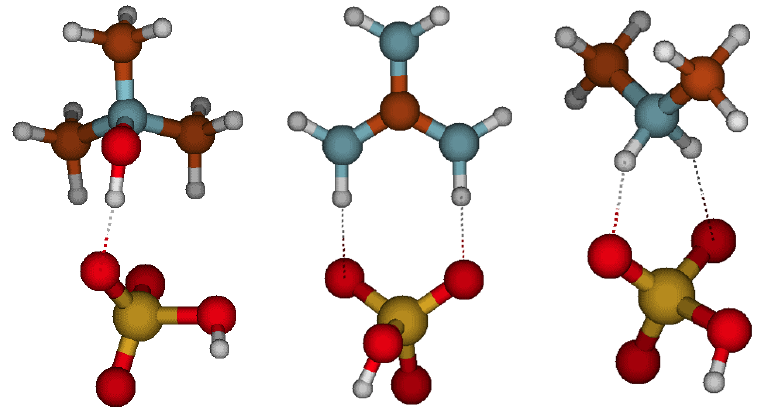
Figure 2. Molecular structures of sulfuric acid heterodimers with trimethylamine oxide (TMAO) ( left ), guanidine (GUA) ( middle ), and dimethylamine (DMA) ( right ). Color coding: Brown is carbon, blue is nitrogen, red is oxygen, yellow is sulfur, and white is